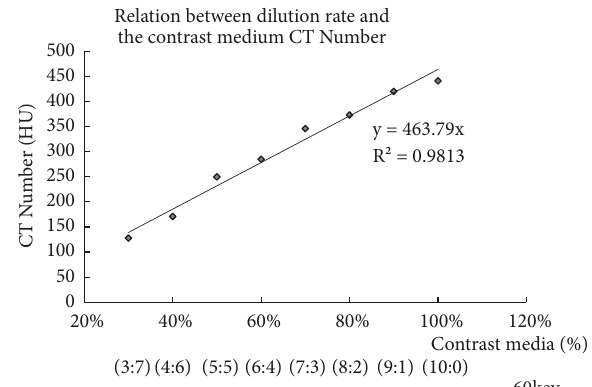
Figure 7: The dilution rate of contrast media and saline, exhibiting a strong correlation (R 2 =